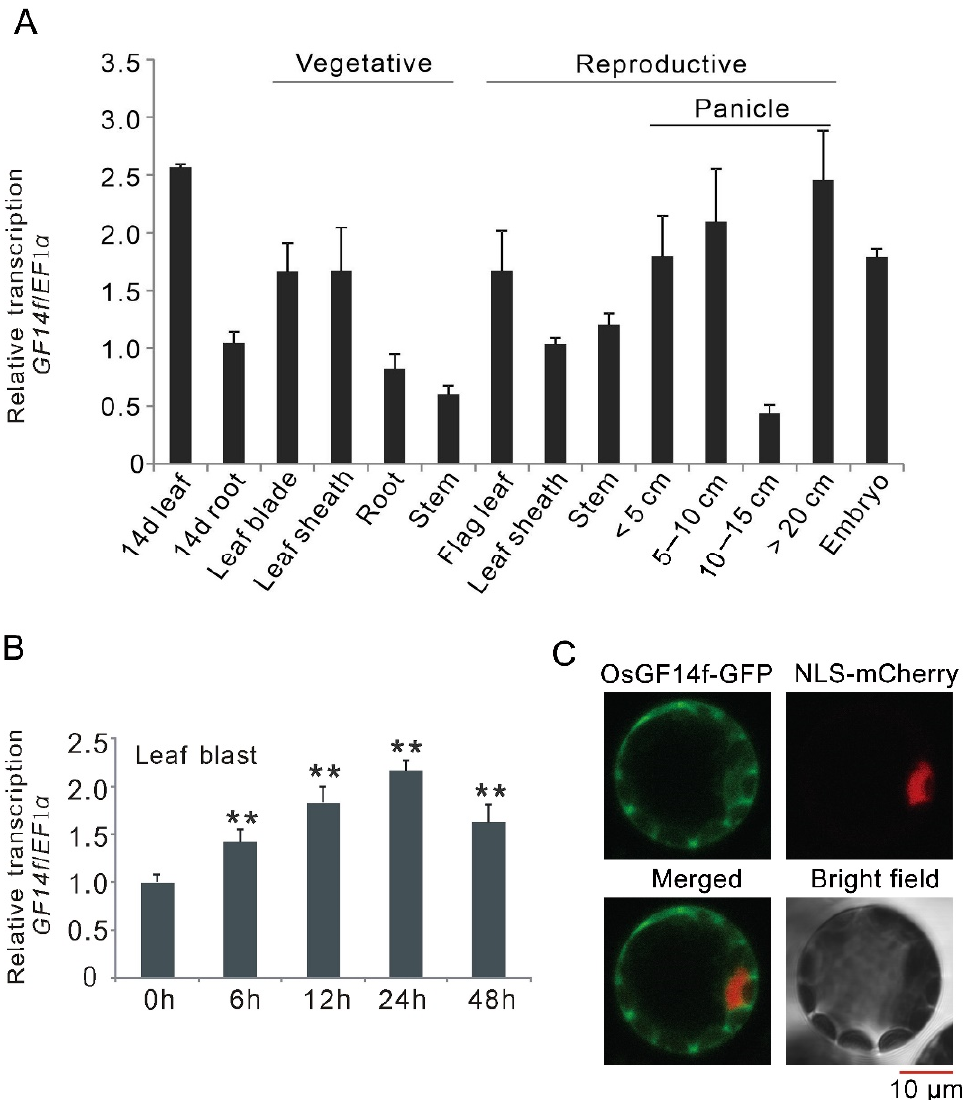
Figure 1. Expression patterns of OsGF14f and subcellular localization of OsGF14f. ( A ) Expression patterns of OsGF14f in different tissues of Nipponbare plants. ( B ) Quantitative RT-PCR analysis of the response of OsGF14f to leaf blast infection. The values 3 h, 6 h, 9 h, 12 h, 24 h and 48 h indicate the time after blast inoculation. ** p < 0.01. ( C ) Subcellular localization of OsGF14f. GF14f-GFP and signal was detected by laser confocal microscopy after 16 h of